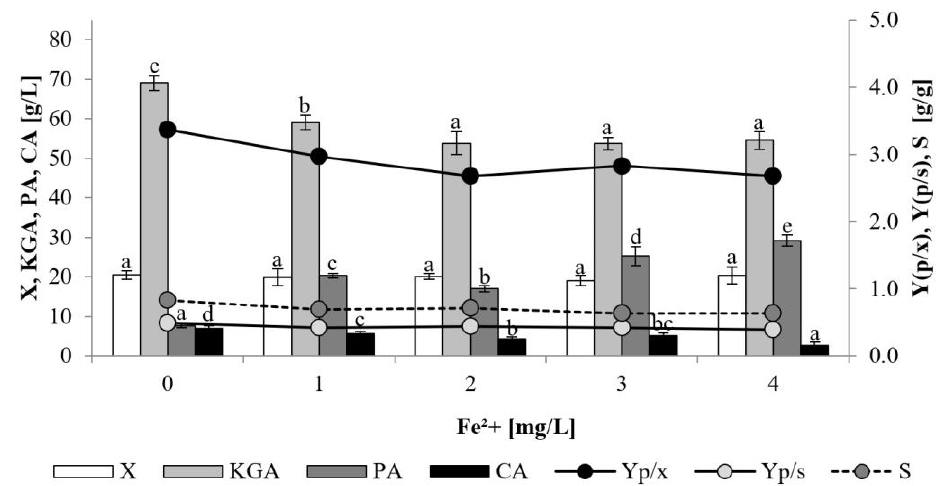
Figure 4. Impact of iron on yeast growth and acids formation during KGA biosynthesis performed by Y. lipolytica CBS 146773 in mixed glycerol/oil-based media. Culture conditions: 20% Ca(OH) 2 , pH 3.5, 800 rpm, 3 µ g/L of thiamine. Abbreviations: X—biomass; KGA— α -ketoglutaric acid; PA—pyruvic acid; CA—citric acid; Y—yield of KGA with respect to biomass formed (p/x) and utilized substrates (p/s); S—selectivity of KGA relative to sum of acids formed (KGA/(KGA + PA + CA)). Mean values for a specific product concentration marked with different letters (a, b, c, . . . ) differ significantly at p ≤ 0.05. Error bars indicate standard